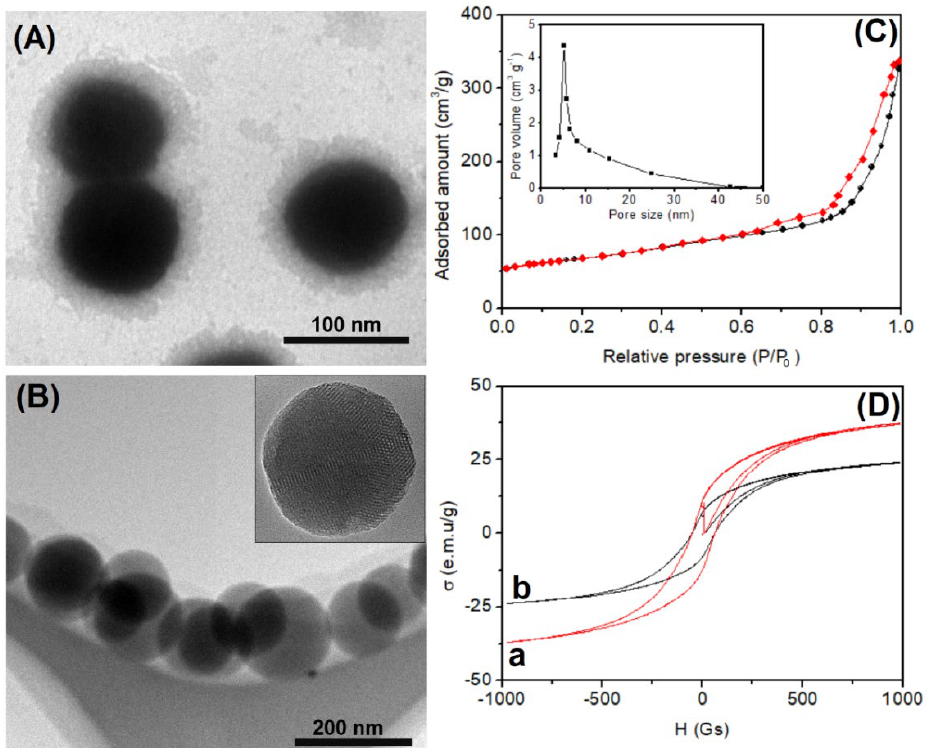
Figure 1. TEM images of ( A ) magnetic beads and ( B ) the aminated magnetic mesoporous silica nanocontainers (inset: the corresponding high-resolution TEM image with 1.5-fold magnification); ( C ) nitrogen adsorption isotherms (inset: pore size distribution); ( D ) hysteresis loops for (a) magnetic beads and (b) aminated magnetic mesoporous silica nanocontainers.